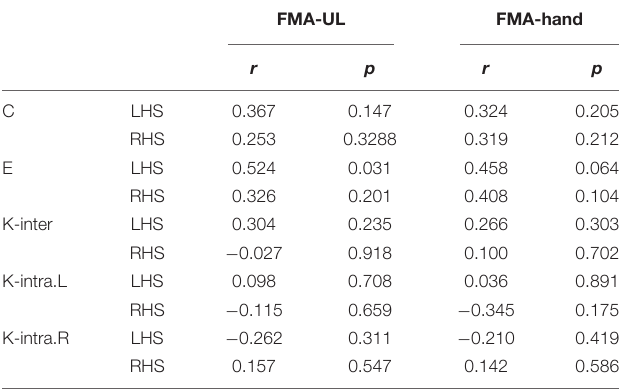
TABLE 2 | Spearman correlation coefficients ( r ) of the AUC of brain network indicators and